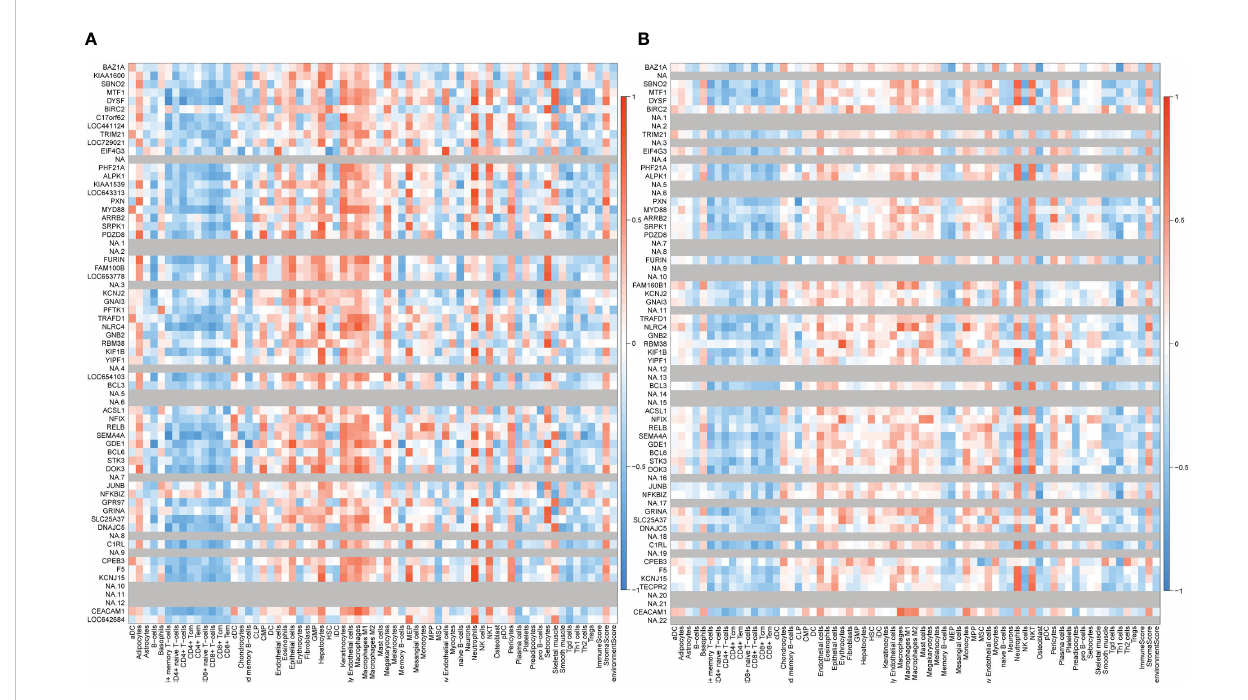
FIGURE 10 Correlation between up-regulated coDEGs and immune cells in validation datasets (A) Correlation between up-regulated coDEGs and immune cells in AS (GSE25101). (B) Correlation between up-regulated coDEGs and immune cells in IBD (GSE94648). (Gray means that the gene was not probed in this